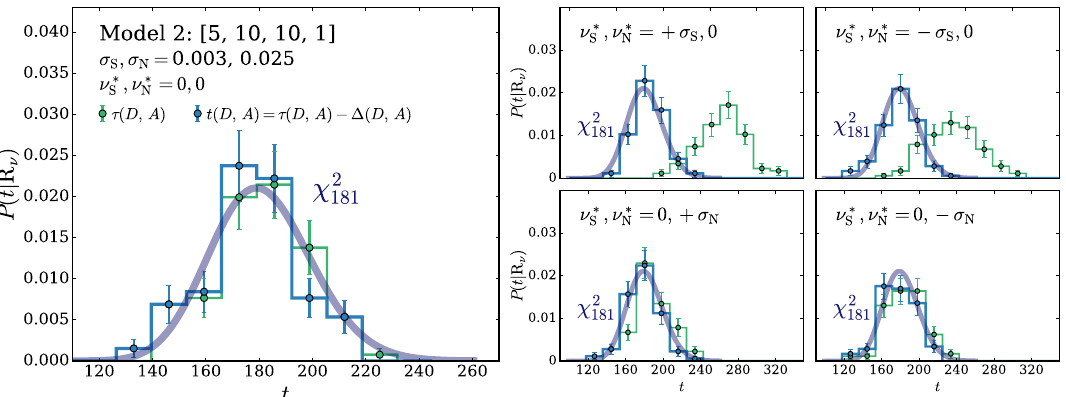
distribution is reported in blue in all the plots 181